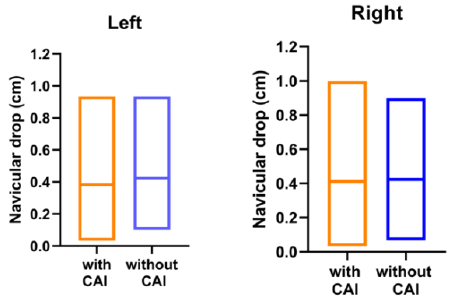
(Table 4). Athletes in the acrobatic group had a significantly higher prevalence of CAI than